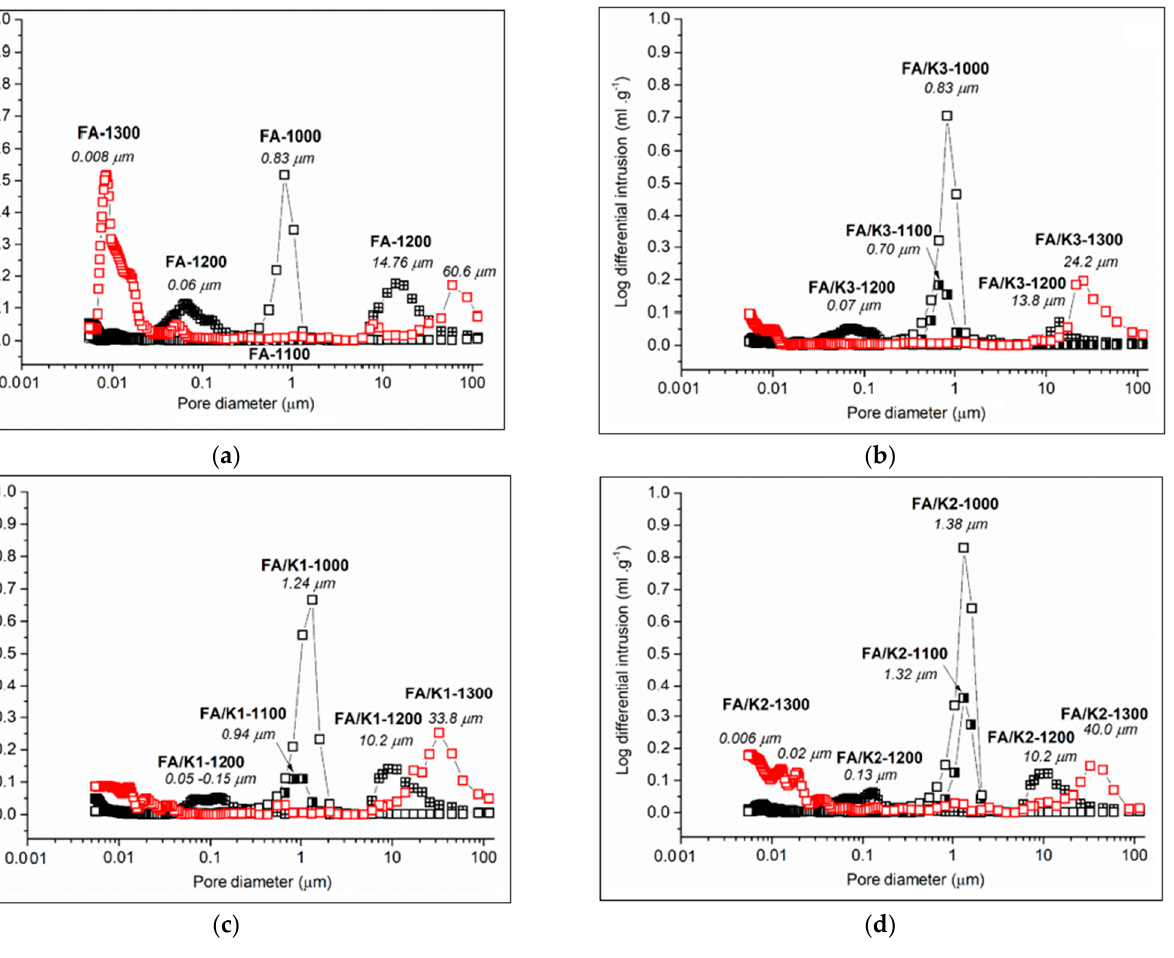
Figure 6. Pore size distribution at 1000, 1100, 1200 and 1300 ◦ C in: ( a ) FA, ( b ) FA/K3, ( c ) FA/K1 and ( d ) FA/K2. The samples annealed at 1000 ◦ C show: (I) unimodal pore size distribution with the pores size region at about 0.83 µ m in FA-1000 and FA/K3-1000; 1.24 µ m in FA/K1-1000 and 1.38 µ m in FA/K2-1000. region with zero pores in FA-1100; 0.70 µ m in FA/K3-1100; 0.94 µ m in FA/K1-1100